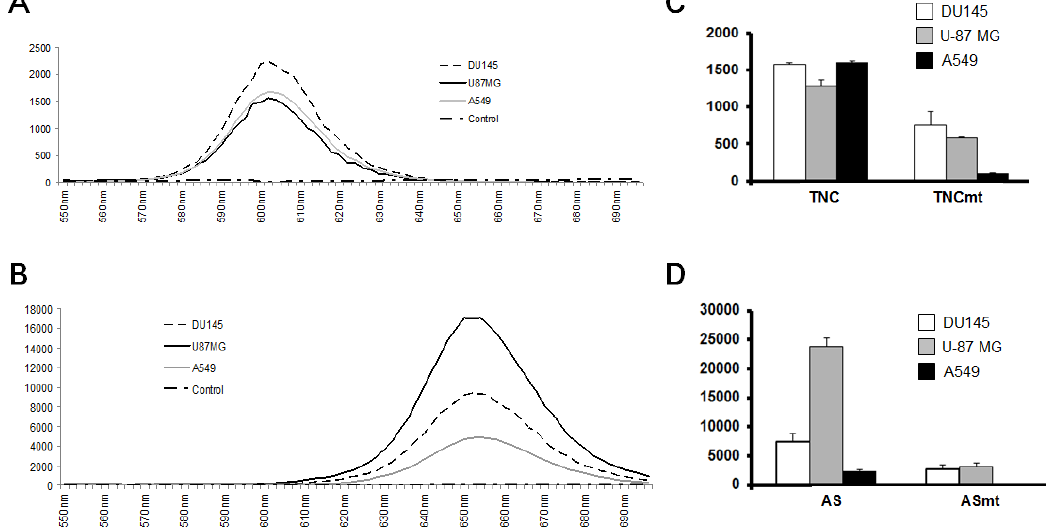
Figure 2. Stability and functionality of QD-aptamer conjugates. Fluorescence emission spectra of ( A ) QD-TTA-1 and ( B ) QD-AS1411 in three cancer cell lines. DU145 (dotted black line), U-87 MG (solid black line), A549 (gray line), and baseline (dash-dotted line); excitation: 480 nm, scanning wavelength: 500–800 nm, with a bandwidth of 10 nm. Fluorescence intensities of ( C ) QD-TTA-1 and QD-TTA-1mt; and ( D ) QD-AS1411 and QD-AS1411mt in three cancer lines. QD-aptamer conjugates were added to cancer cells and the fluorescence intensity was measured. Data are displayed as means ± standard deviations of triplicate